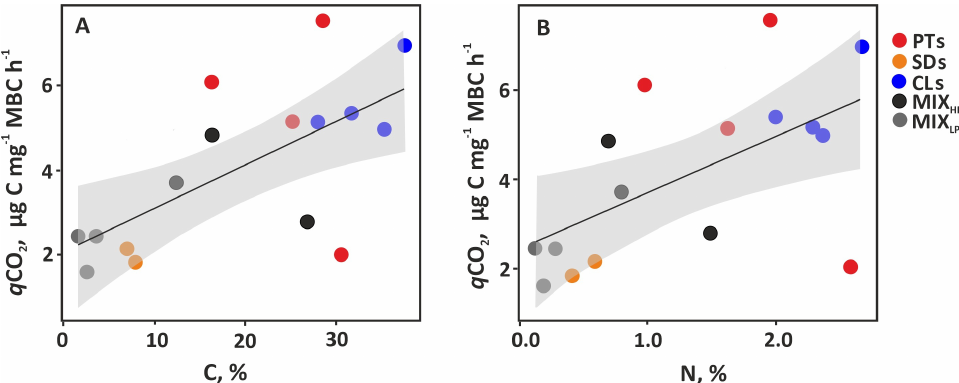
Figure 5. Scatter plot for microbial ( q CO 2 ) and carbon ( A ) and nitrogen ( B ) of the soil-like materials. The gray ‘bands’ represent the standard error of the regression